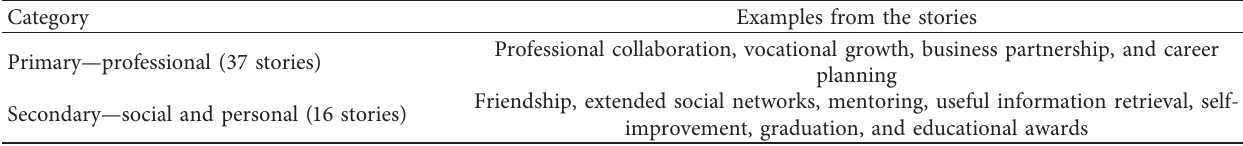
Table 6: Categories of valuable outcomes identified in respondents’